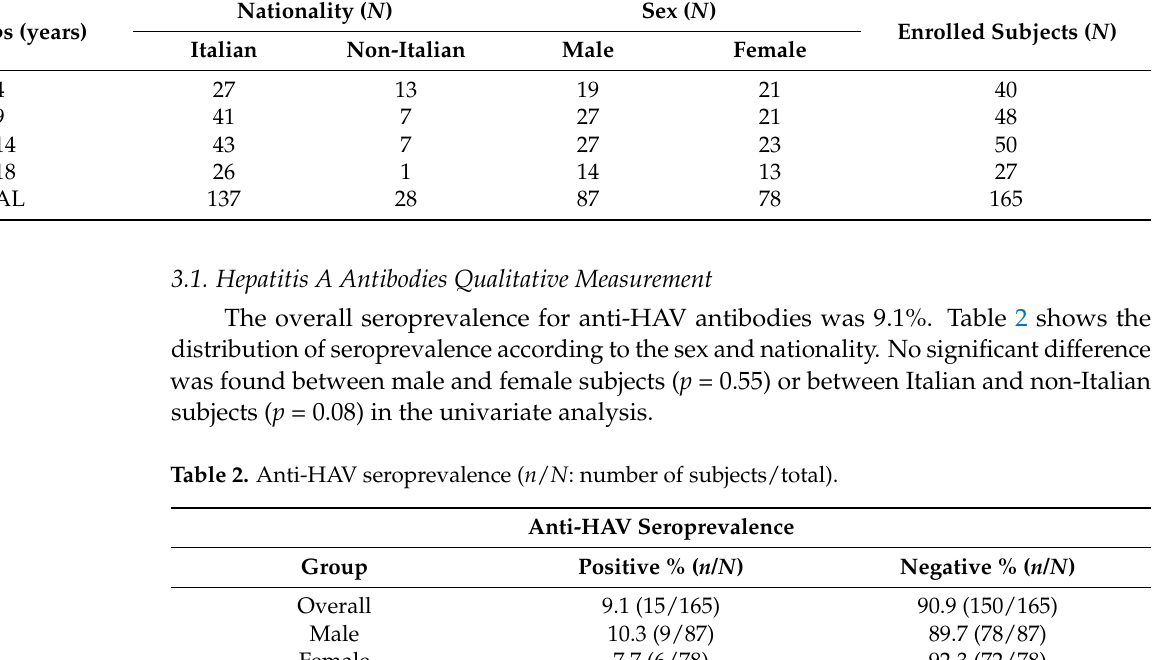
Table 1. Subjects distribution in the age groups of the study population according to sex and nationality. Age Groups (years)